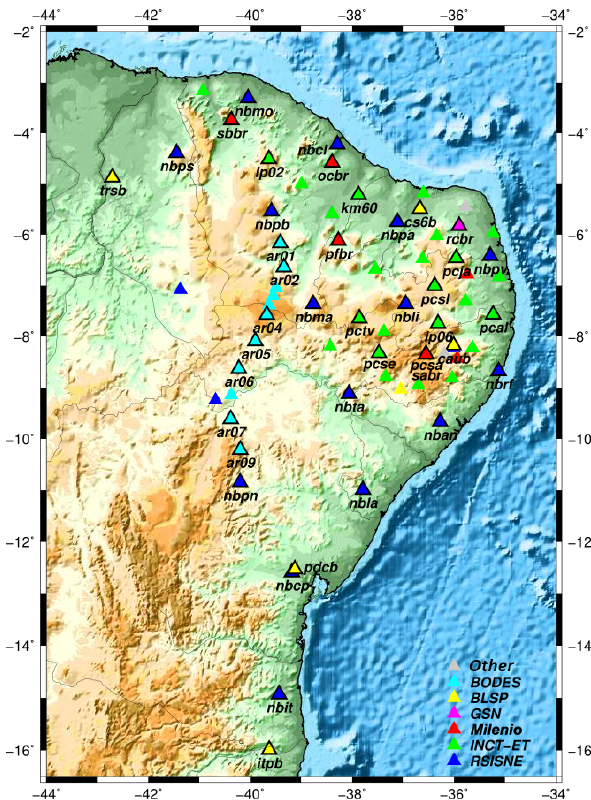
Figure 2. Topographic map of northeast Brazil with locations of broadband and short-period stations considered in this study. Sta- tions are color-coded by network: stations from the RSISNE net- work are represented by dark blue, INCT-ET by green, Milenio by red, GSN by pink, BLSP by yellow, BODES by light blue and “other” networks by grey (see legend). Only the selected stations have been named and are represented using black